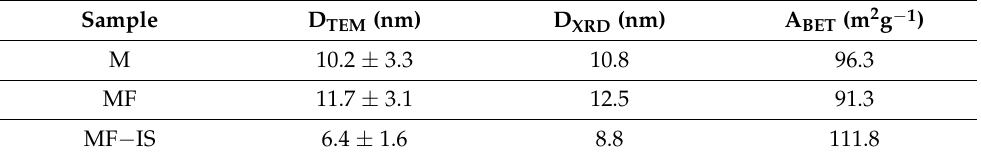
Table 2. Average crystal sizes measured in TEM image (D TEM ), average crystallite sizes obtained via X-ray diffraction (D XRD ) and specific surface area (A BET ) of magnetite (M), post-synthesis fucoidan- coated magnetite (MF), and in situ fucoidan-coated magnetite (MF − IS) samples. Sample